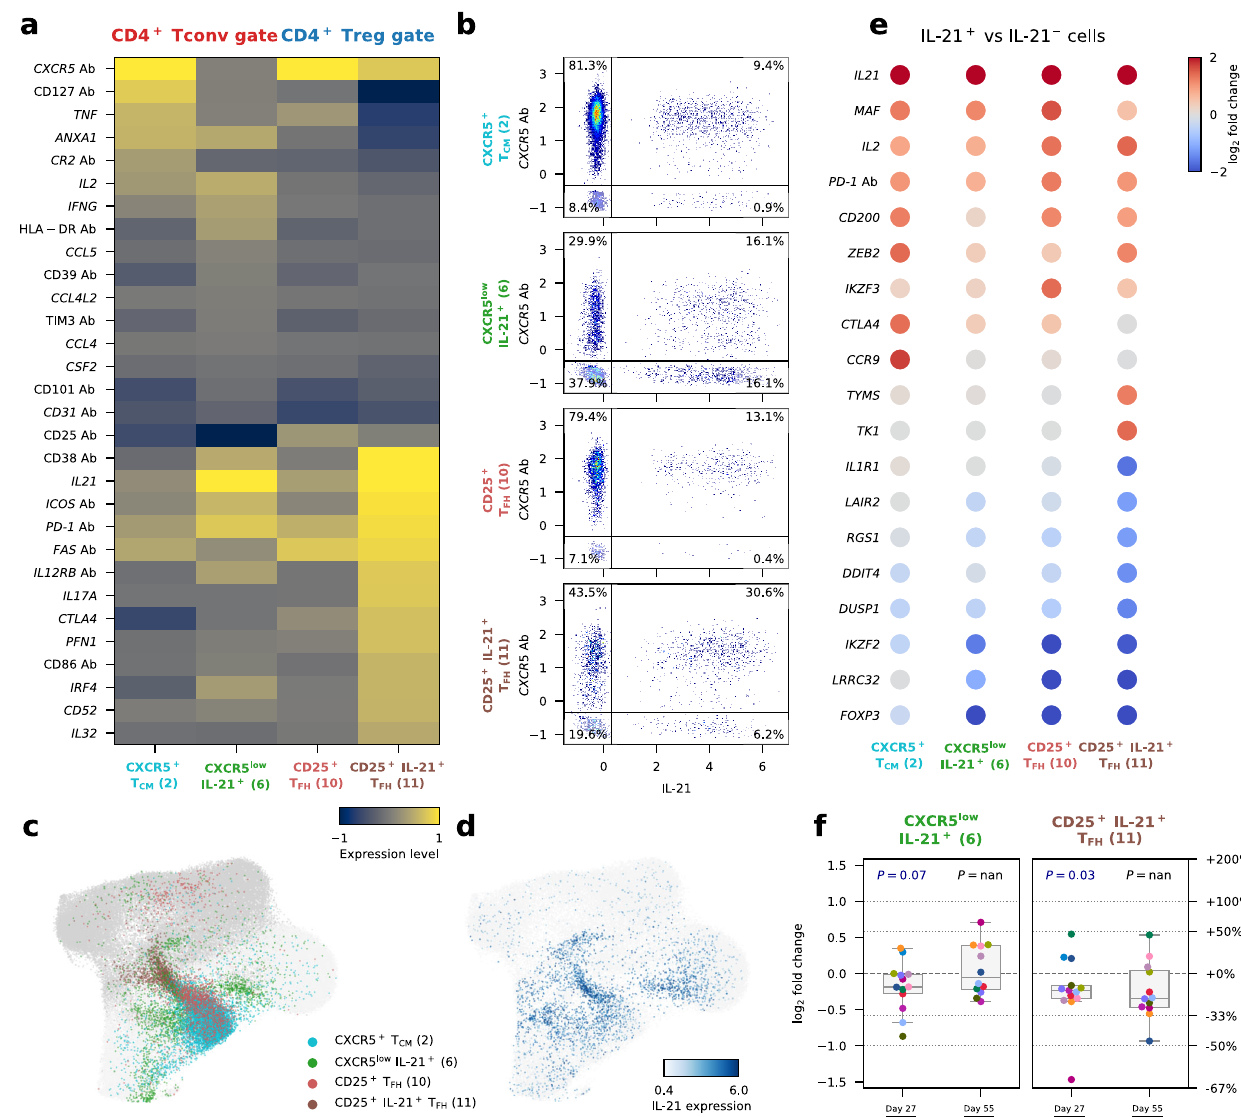
Fig. 3 | Low-dose IL-2 treatment inhibits the differentiation of IL-21-producing CD4 + T cells. a Expression levelsof 30 differentially expressed markers in the four assessed IL-21-producing CD4 + T cell subsets from in vitro stimulated CD4 + T cells: CXCR5 + T CM and CXCR5 low IL-21 + sorted from the CD25 – /low Tconv gate; and CD25 + T FH and CD25 + IL-21 + T FH sorted from the CD127 low CD25 hi Treg gate. b Expression of CXCR5 (AbSeq) and IL21 in the four assessed IL-21 + CD4 + T cell subsets. c , d UMAP plotsdepicting theclusteringofinvitrostimulated CD4 + Tcells( n =209,543cells). Cells are coloured according to the respective IL-21 + cluster assignment ( c ); or by normalised and scaled IL-21 expression levels ( d ). Dark and light grey denote cells sorted from the CD127 low CD25 hi Treg gate and CD25 – /low Tconv gate, respectively, that are not in IL-21 + clusters. e Gene expression changes between IL-21 + and IL-21 – cellswithineachofthefourassessedIL-21 + CD4 + Tcellclusters.Geneswithabsolute log 2 fold change>=1.2and FDR-adjusted P values<0.01inatleastoneclusterwere